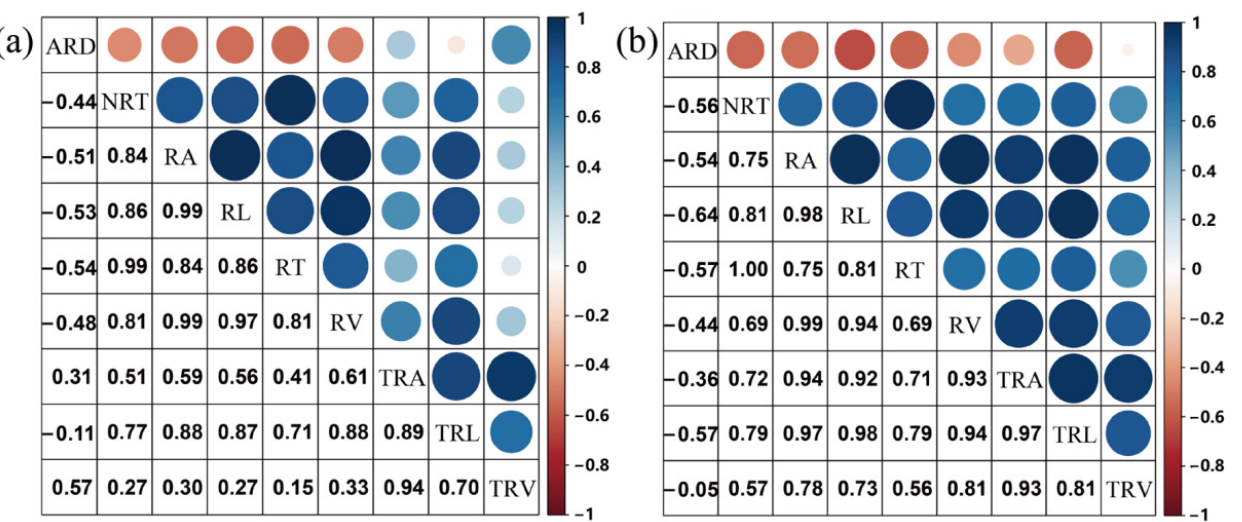
The relationships between the nine traits were calculated (Figure 3). The results showed that significant positive correlations were observed between eight RSA traits, except for ARD. ARD showed a significant negative correlation with NRT, RL, RA, RV, and RT in the two environments. The correlation coefficients between RL, RA, and RV were higher than 0.94 in the two environments, indicating that these three traits were strongly correlated.